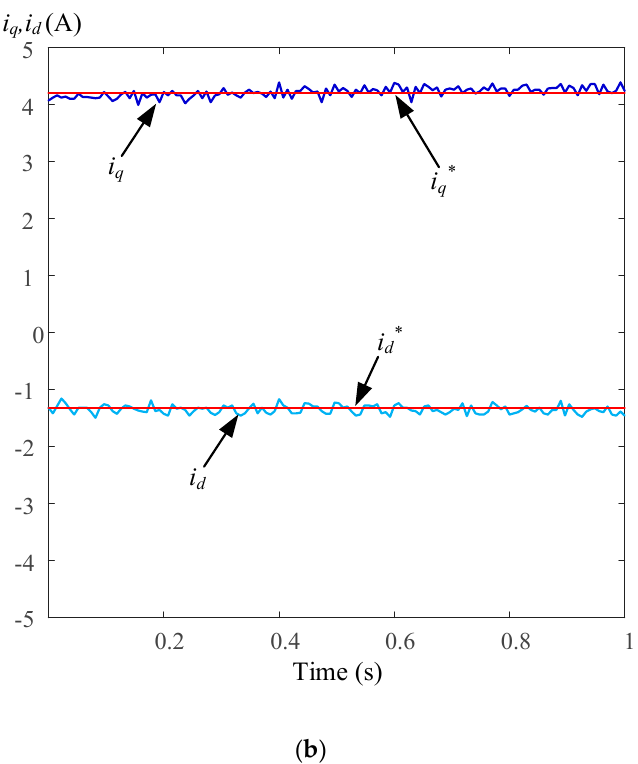
Figure 19. Measured responses at 300 r/min without fl ux-weakening control. ( a ) speeds, ( b ) currents.